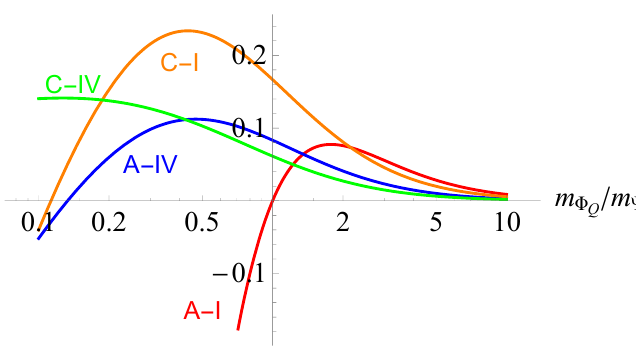
(cid:0) (cid:1) m (cid:8) =m (cid:9) entering C for the four Majorana representations A-I, B (cid:22) B Q